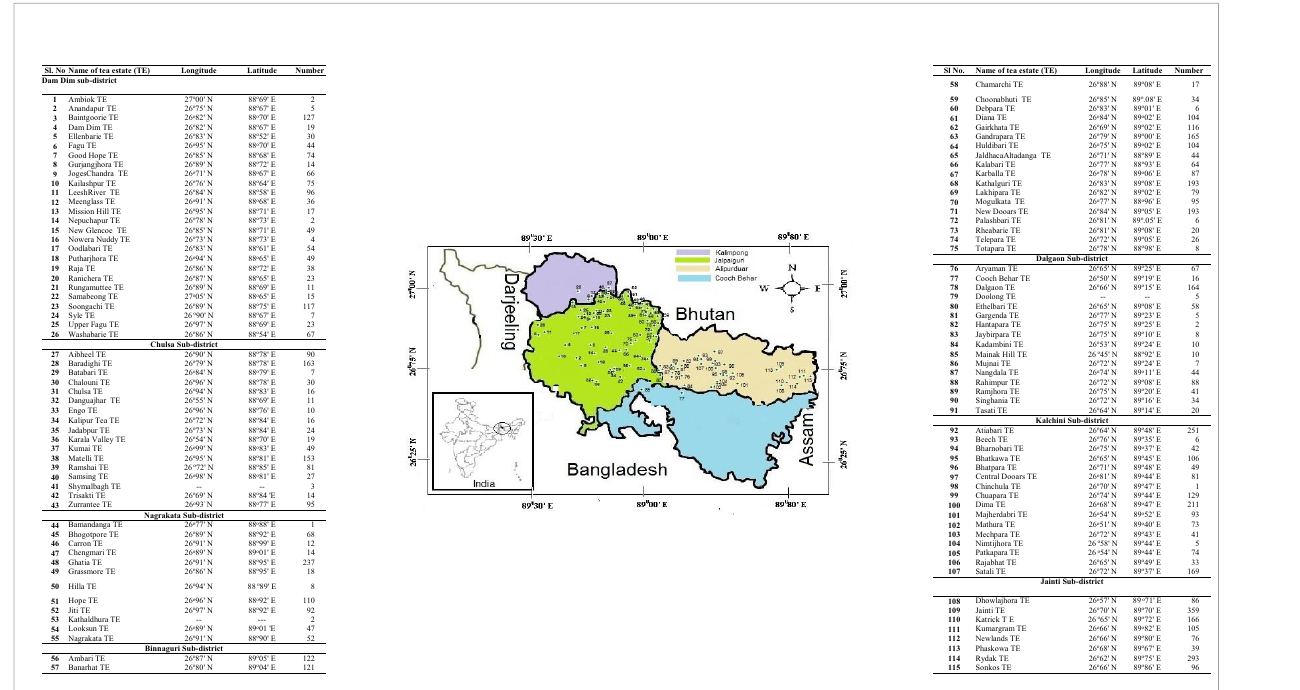
FIGURE 1 Details of 7300 soil samples collected from 115 tea estates spread over seven sub-districts of Dooars, West Bengal,